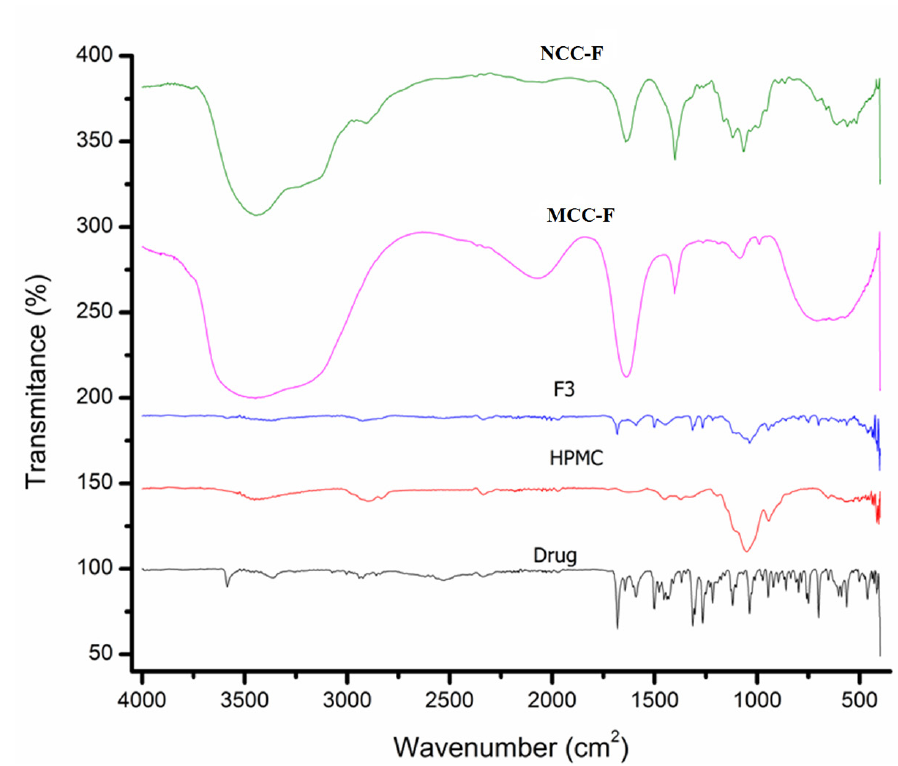
FIGURE 2 - FTIR images of pure drug and various sizes of cellulose mixed Oro dispersible